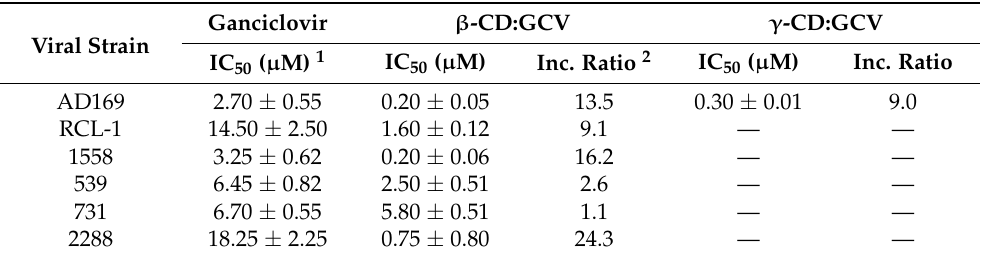
Table 2. In vitro inhibitory activity of ganciclovir and 10:1 associations of β -CD and γ -CD with ganciclovir on fibroblasts infected with various strains of human cytomegalovirus (HCMV). Viral